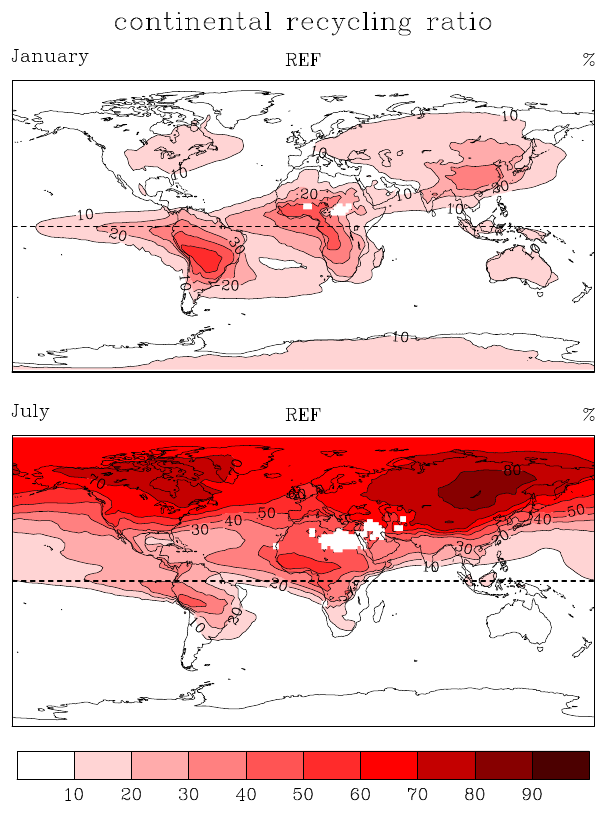
Fig. 3. Surface evaporation E (colours, kgm − 2 d − 1 ) and horizontal moisture flux density Q (arrows, kgm − 1 s − 1 ) in the REF experi-